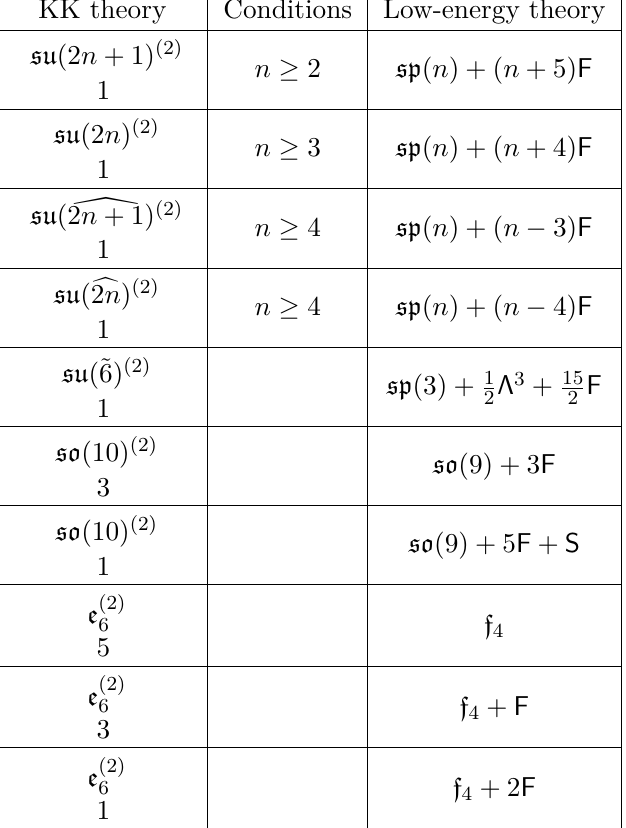
Table 2 . Low-energy 5 d non-abelian gauge theories associated to 5 d KK theory building blocks involving twists of first